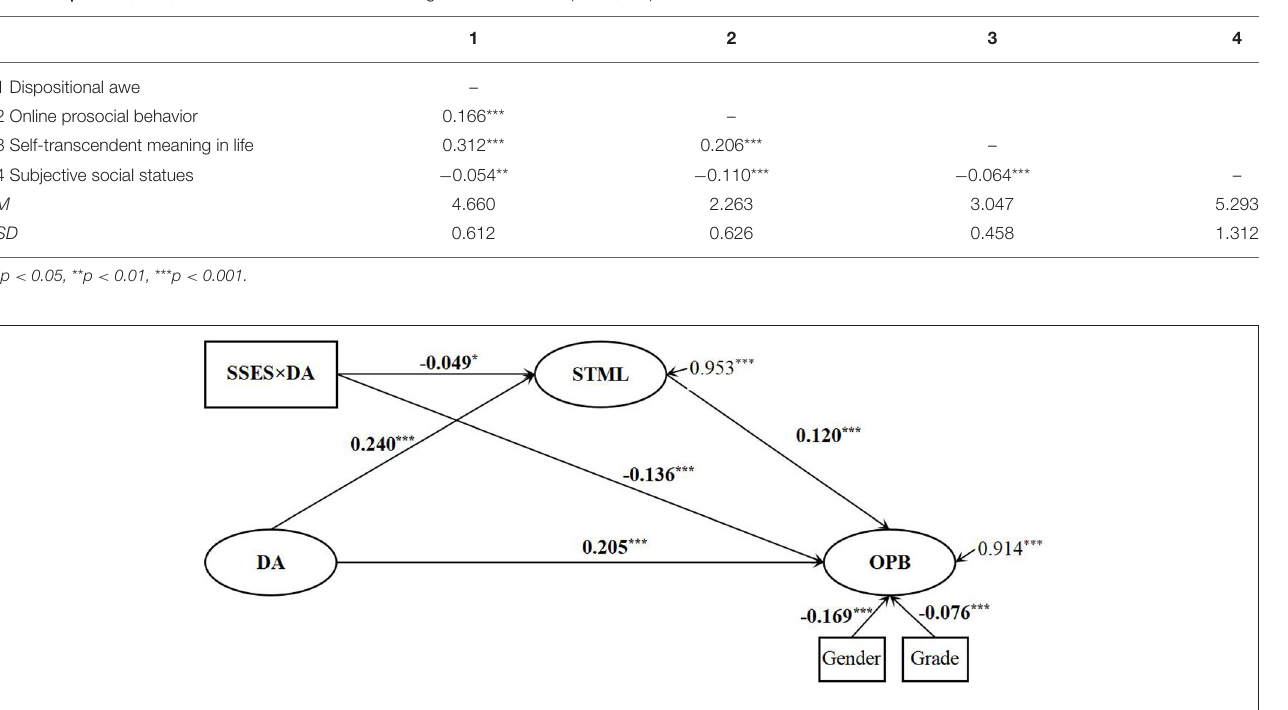
TABLE 1 | Means, SDs, and Pearson’s correlations among studies variables ( n = 3,080).